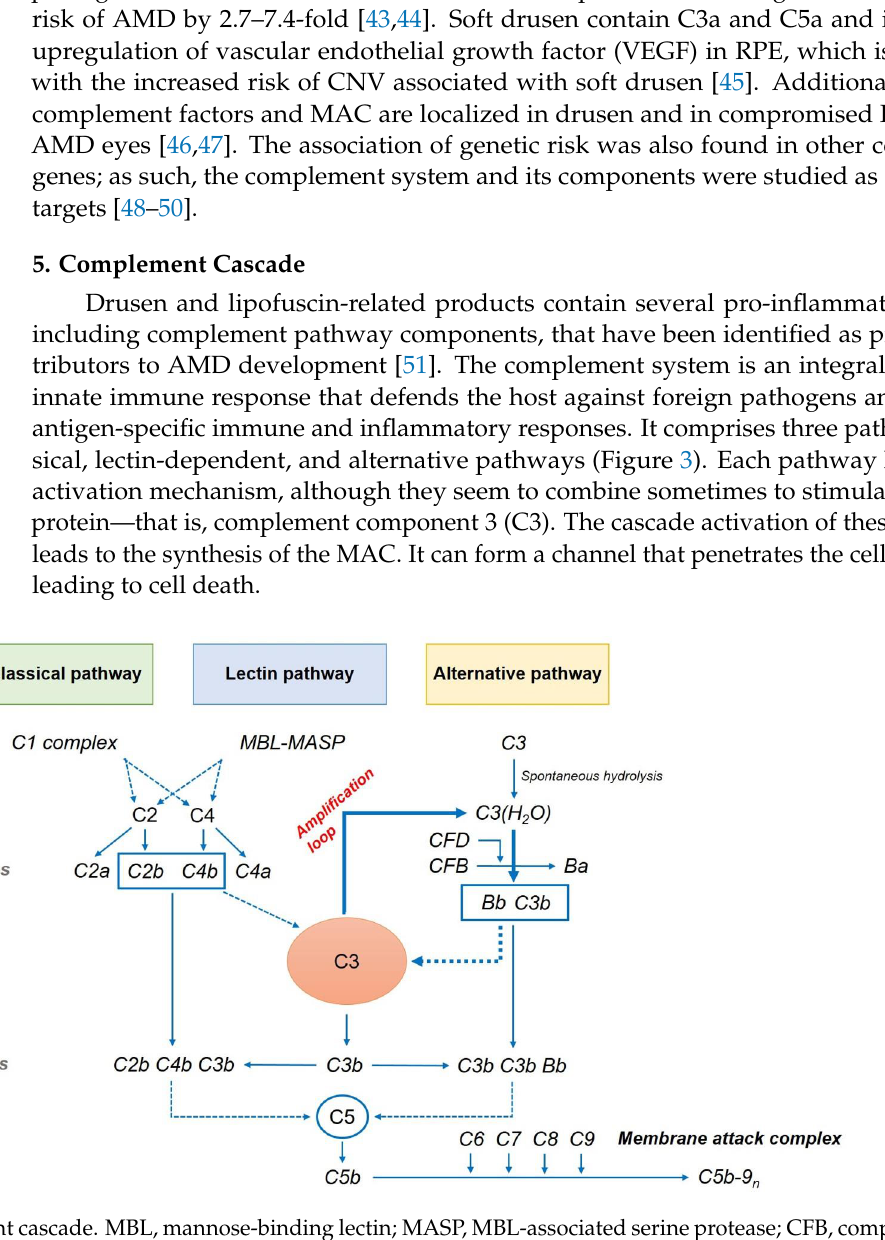
Figure 3. The complement cascade. MBL, mannose-binding lectin; MASP, MBL-associated serine protease; CFB, complement factor B; CFD, complement factor D.